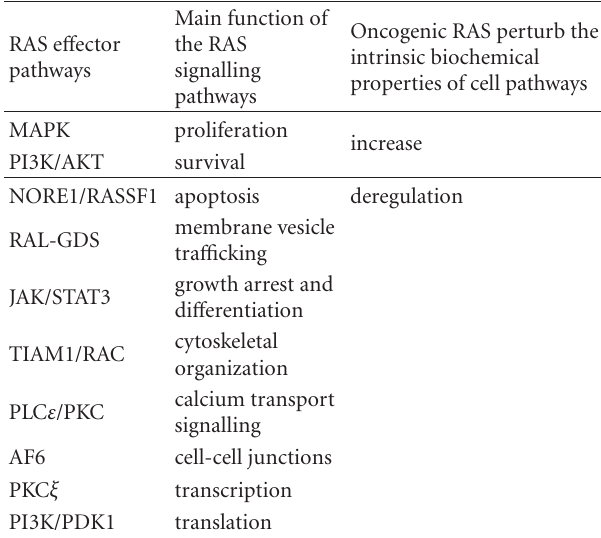
Table 1: Consequences of oncogenic KRAS on cellular physiology and